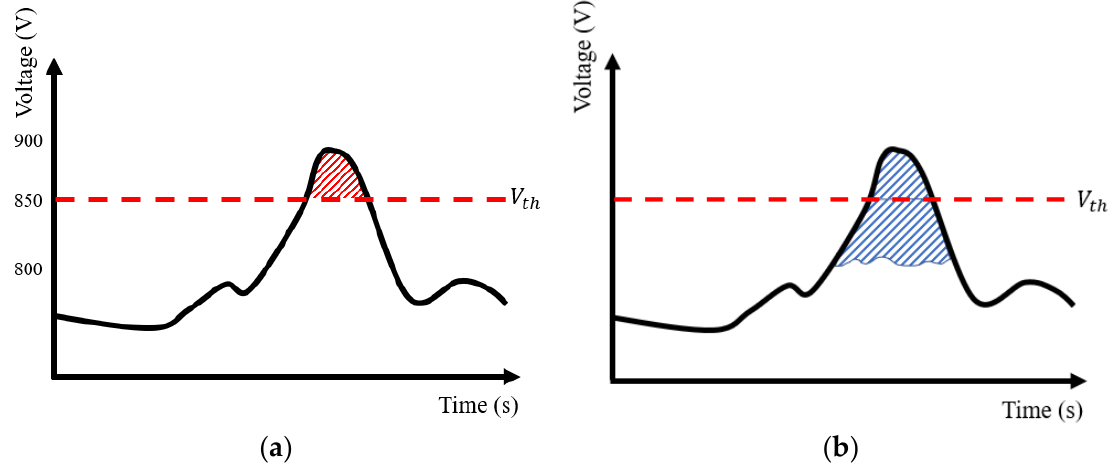
Figure 7. ( a ) Energy utilization area according to the conventional inverter operation method. ( b ) Energy utilization area according to BP method.